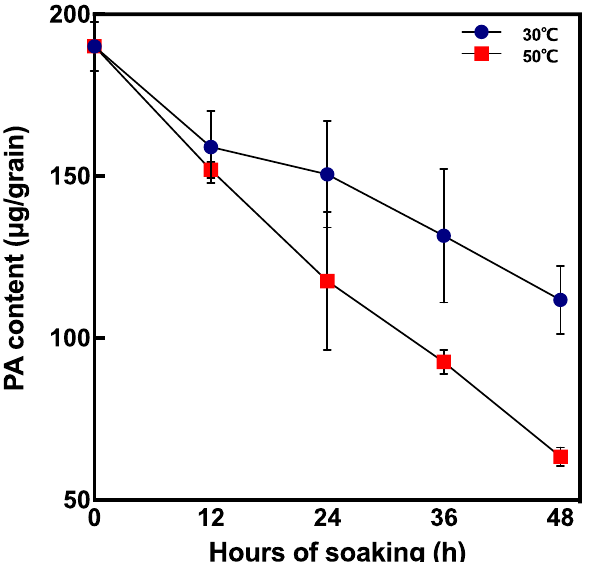
Figure 6. Changes in PA content in short periods after soaking at 30 °C and 50 °C. Data are shown as the mean ± standard deviation from 3–5 replicates.